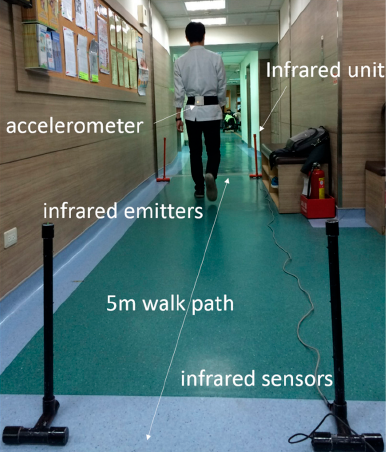
Figure 1. The wireless accelerometer unit was attached to the L3–L4 spinal segment of the lower back using an elastic belt.